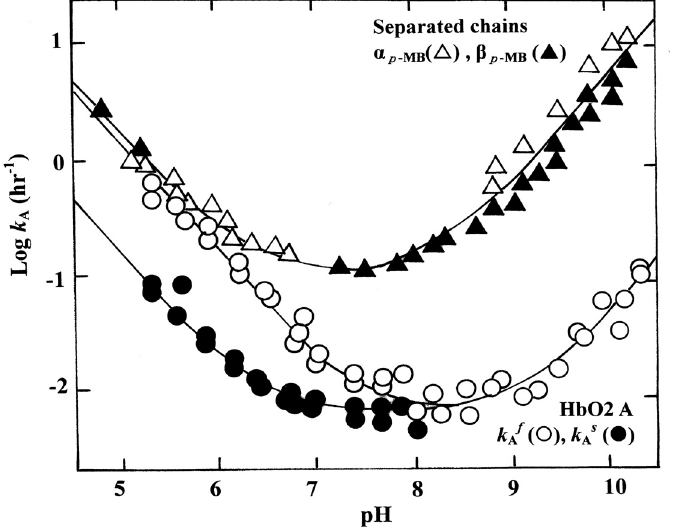
Figure 4. Logarithmic values of first-order rate versus pH plot for isolated α - and β -chain autoxidation with a reference to the relevant values ( k Conditions: the concentration of isolated α and β chains was 50 μ M (in heme contents); the reaction rate was measured in 0.1 M buffer at 37